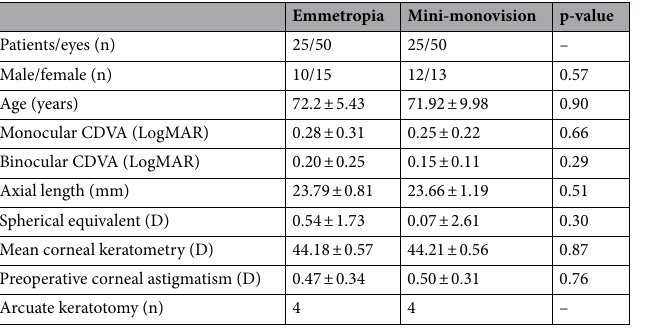
Table 1. Patient characteristics and ophthalmic measurements of patients bilaterally implanted with the Eyhance ICB00 intraocular lens. Data are expressed as mean ± standard deviation. CDVA corrected distance visual acuity, D diopter, logMAR log of the minimum angle of